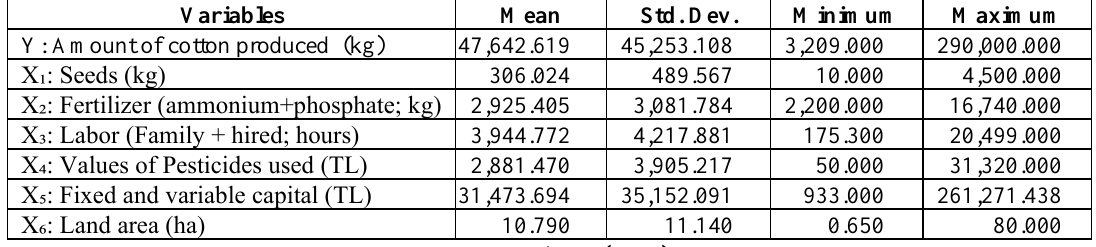
Table 3: The input variables' descriptive statistics for estimating stochastic frontiers.